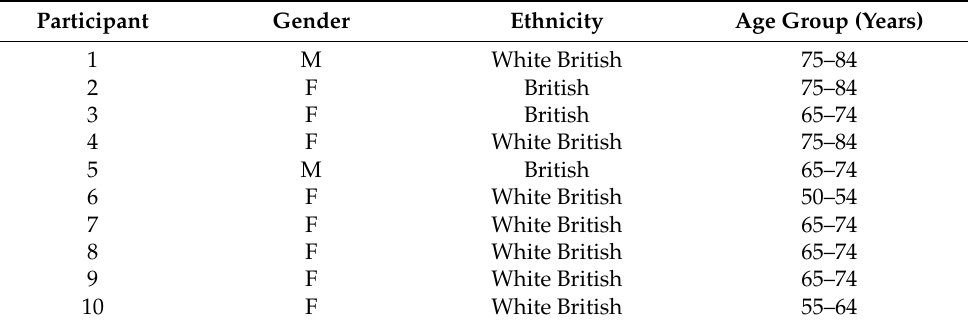
Table 2. Demographic profile of the